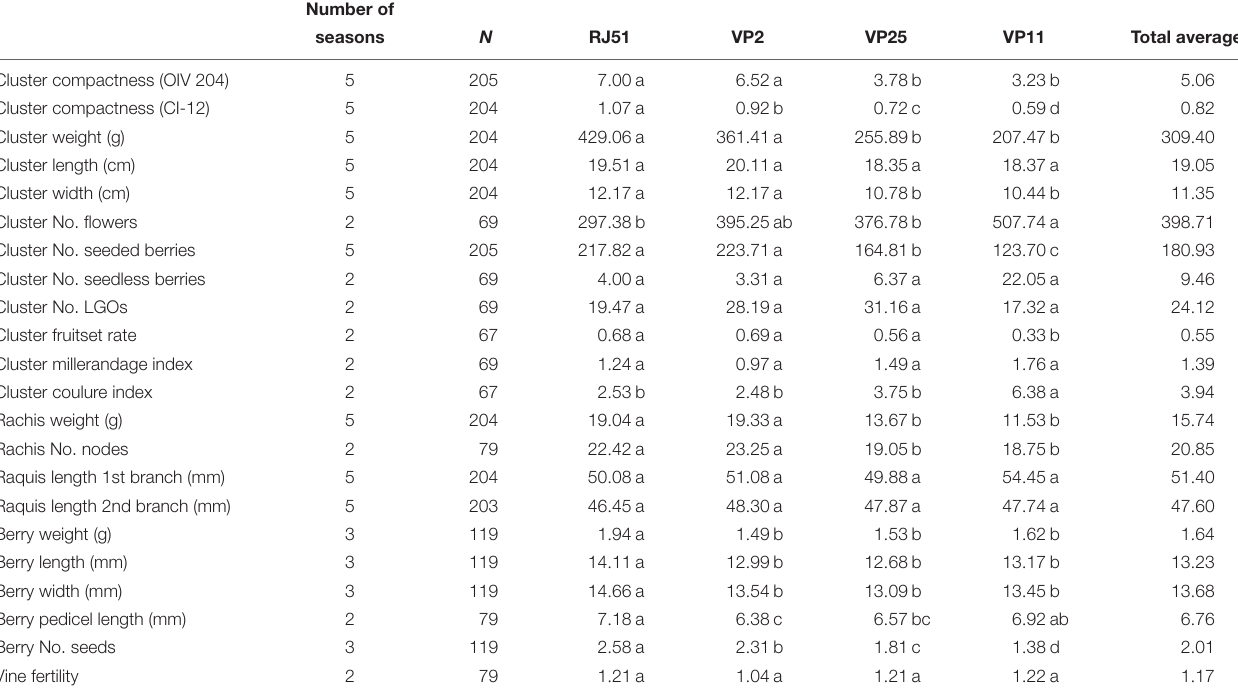
TABLE 1 | Average phenotypic data from two, three, or five seasons data of the four Tempranillo clones under study. Number of seasons N